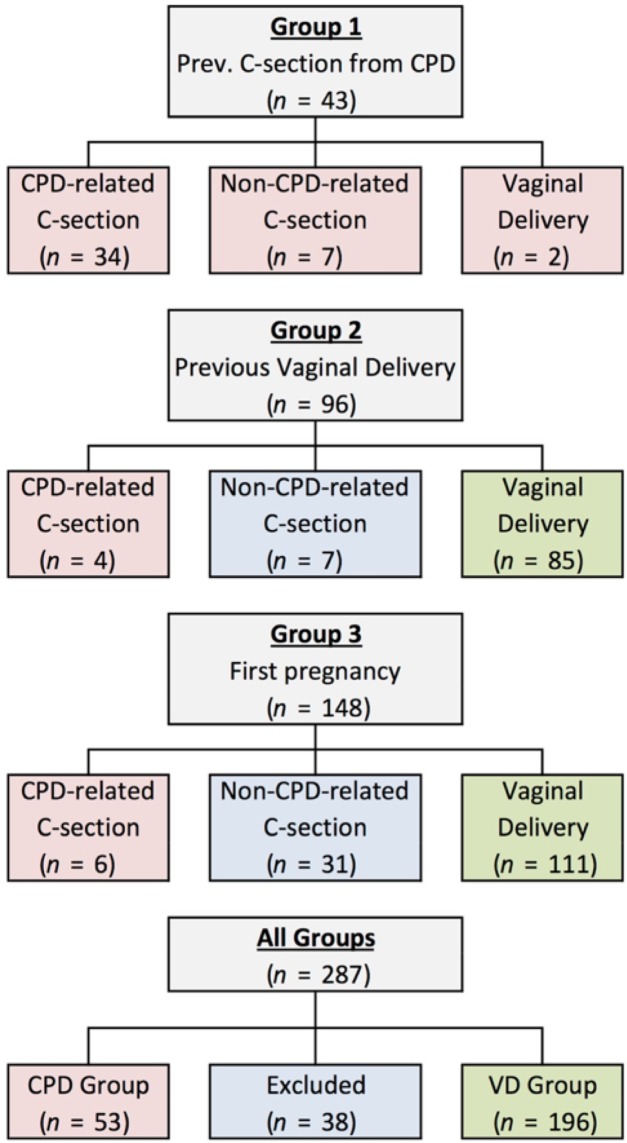
Pregnancy outcomes.Pregnancy outcomes were categorized as CPD-related C/S, non-CPD-related C/S, or VD. Based on both obstetric history and outcome of the current pregnancy, subjects were categorized into two groups: CPD (shaded red) or VD (shaded green). Exclusions are shaded in blue.